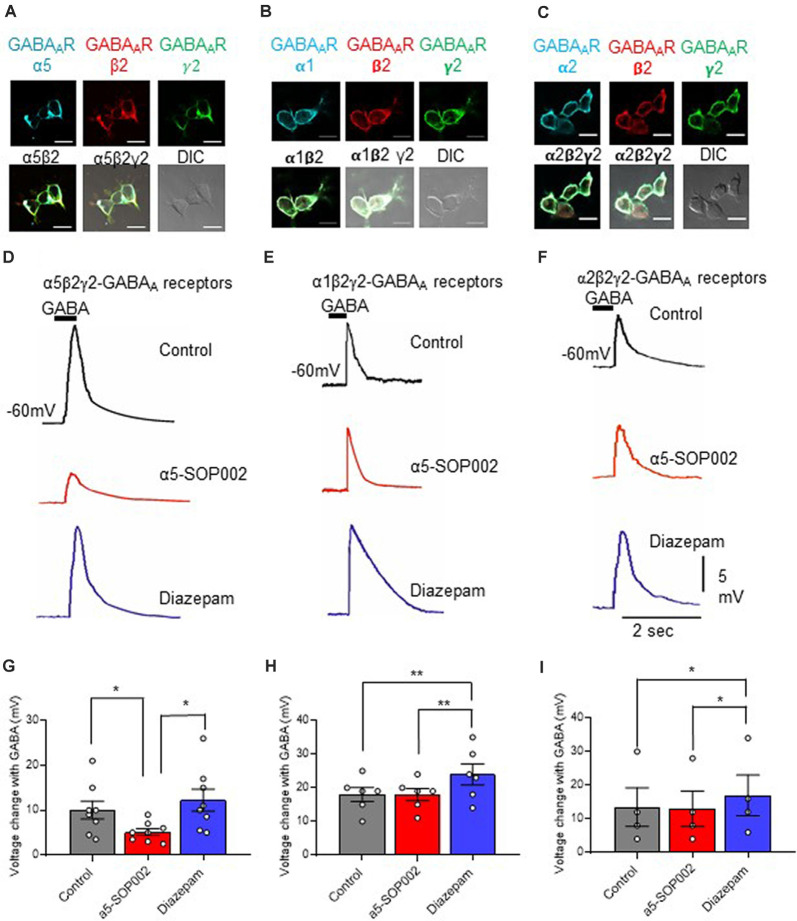
α5-SOP002 selectively targets α5 subunits of GABAARs. Whole-cell recordings in α5β2γ2-, α1β2γ2-, and α2β2γ2-HEK293 cells. HEK293 cells stably expressing α5β2γ2- (A), α1β2γ2- (B), or α2β2γ2-GABAARs (C). Immunofluorescent imaging with a 40× oil immersion objective lens shows cell surface expression of α5, α1 or α2- (cyan), β2- (red), and γ2-GABAAR subunits (green). (A–C) also show all the three channels merged showing α-, β2-, and γ2-GABAAR subunit co-localization at the cell surface (white) along with the differential interference contrast microscopy (DIC) image of the cells. The scale bar represents 10 μm. All three stable cell lines responded to 10 μM puff-applied GABA (D–F) in control extracellular solution (black traces), an extracellular solution containing 1 μM α5-SOP002 (red traces), and subsequent bath application of diazepam (blue traces) at a holding membrane potential of −60 mV. The corresponding plots for α5β2γ2-HEK293 cells (G–I) show the changes in voltage changes in response to 10 μM GABA puffed locally, in the presence of bath-applied α5-SOP002, and, subsequent addition of diazepam. Only the α5β2γ2-HEK293 cells showed an inverse agonist effect (response to GABA) of α5-SOP002. All three cell lines, however, showed an enhancement of response to GABA in the presence of diazepam. Statistically significant data are shown with *P < 0.05 and **P < 0.01.